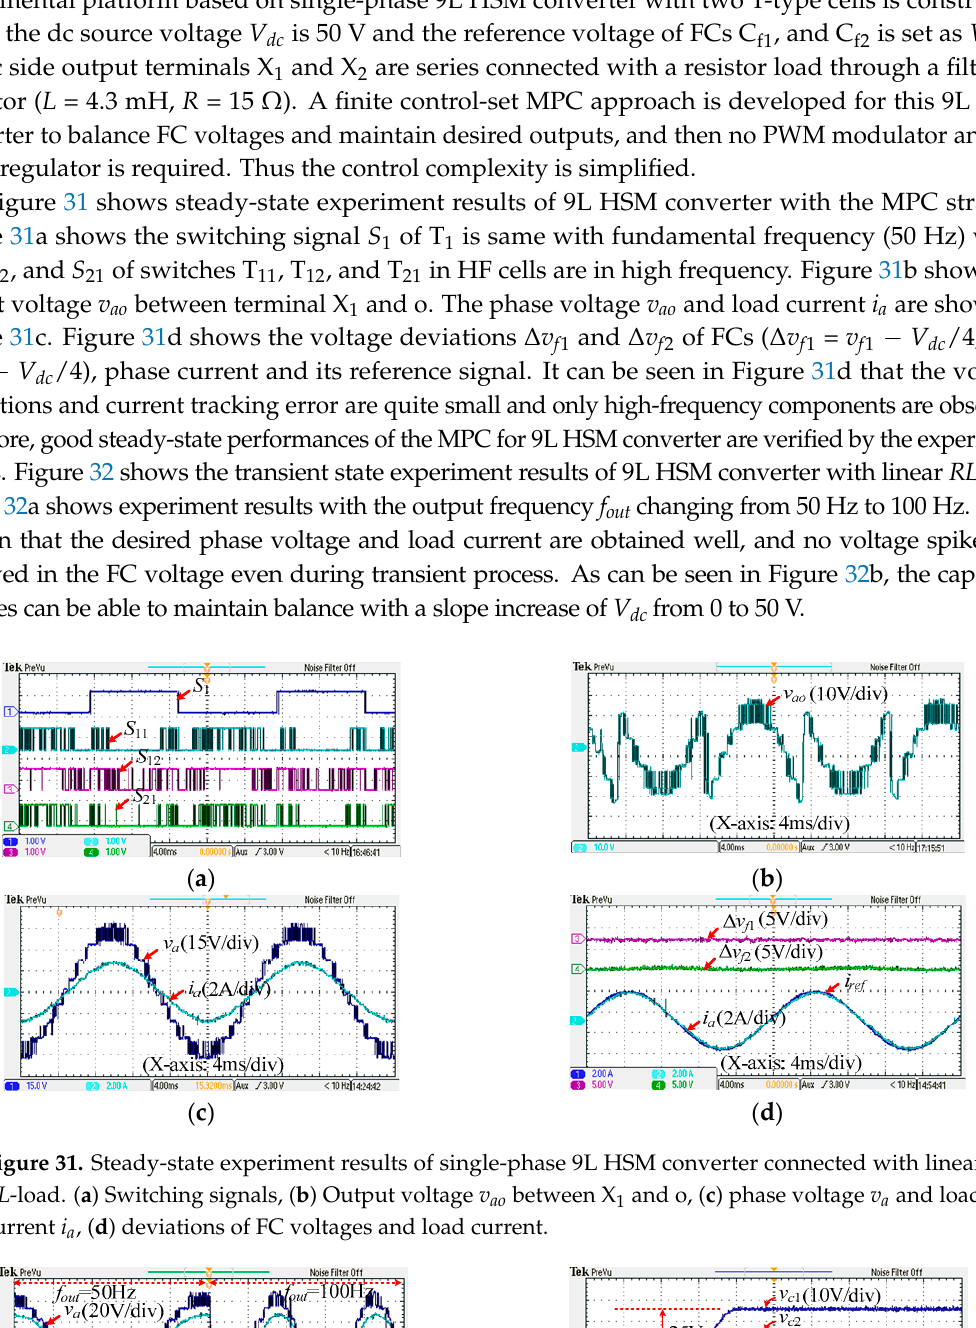
Figure 30. FFT spectrums of phase current i a for ( a ) 5L hybrid T ‐ ANPC converter, ( b ) 7L hybrid T ‐ ANPC converter.